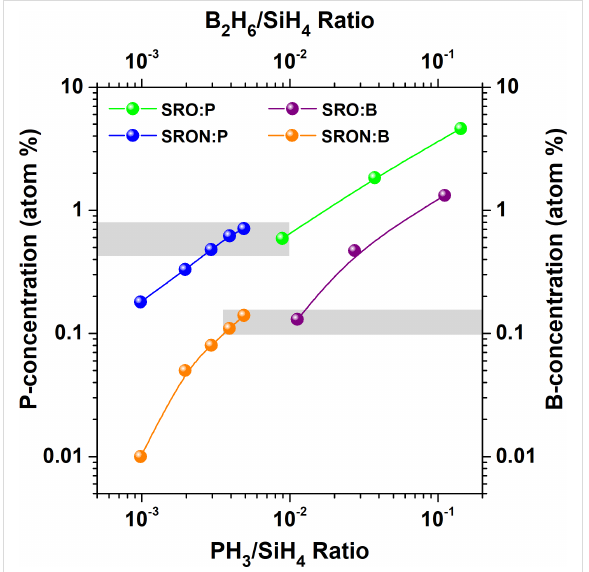
Figure 1: P- and B-concentrations as measured by MCs + -SIMS as function of PH 3 to SiH 4 gas flow ratio, or respectively, as function of B 2 H 6 to SiH 4 gas flow ratio for both SRO and SRON PECVD-recipes. The lines are just a guide to the eye to indicate the nearly linear dependences. The grey boxes indicate the concentration overlap regions for P- and B-doped SRO and SRON materials, respectively.